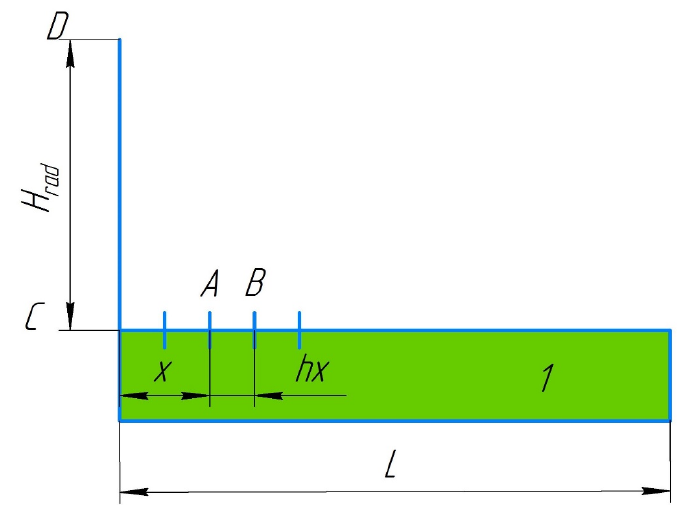
Figure 2. Scheme of radiant heat flux calculation.